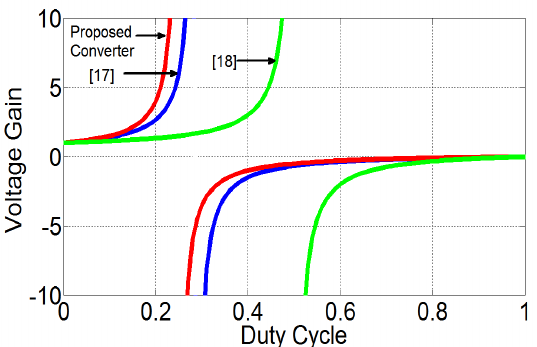
Figure 10. Output voltage gain verse the duty cycle for the introduced topology, topology [17], and topology [18], with the same turns ratio (n = 1.5). Table 1. Comparison of the proposed converter and the similar topologies.